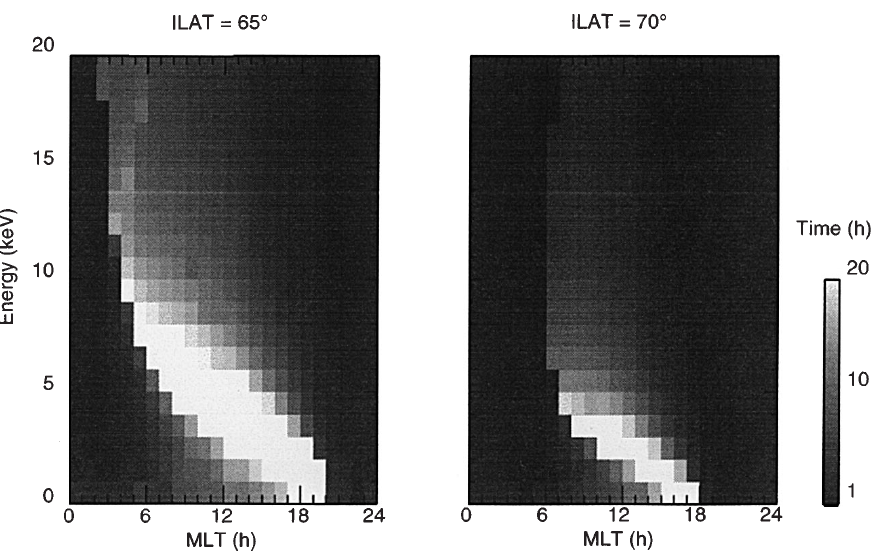
Fig. 6. Proton residence time (coded according to the color scale at right ) as a function of MLT and energy at the observation point. These calculations are shown for two distinct initial ILATs: ( left ) 65 (cid:176) and ( right ) 70